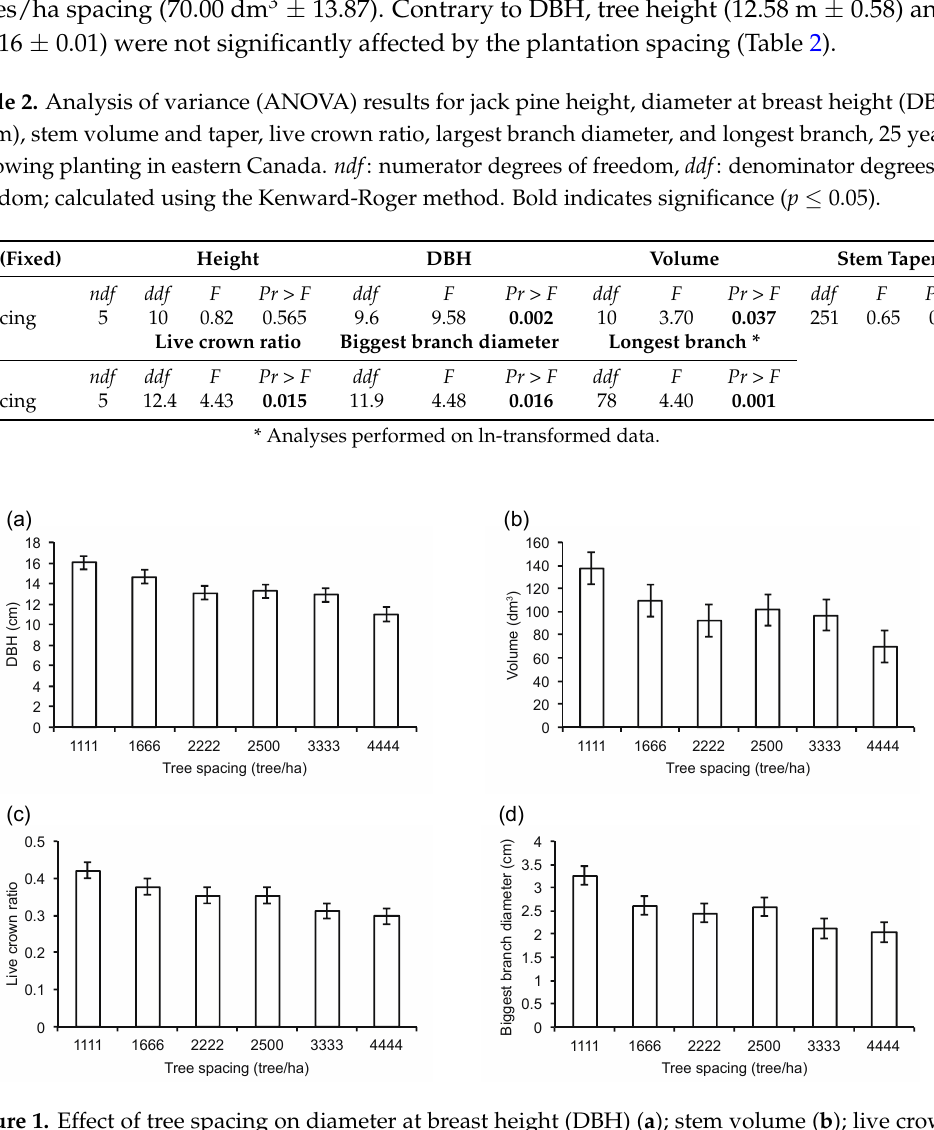
Figure 1. Effect of tree spacing on diameter at breast height (DBH) ( a ); stem volume ( b ); live crown ratio ( c ); and largest branch diameter ( d ) for jack pine 25 years following planting in Quebec, Canada. Data presented are the means (±SE).